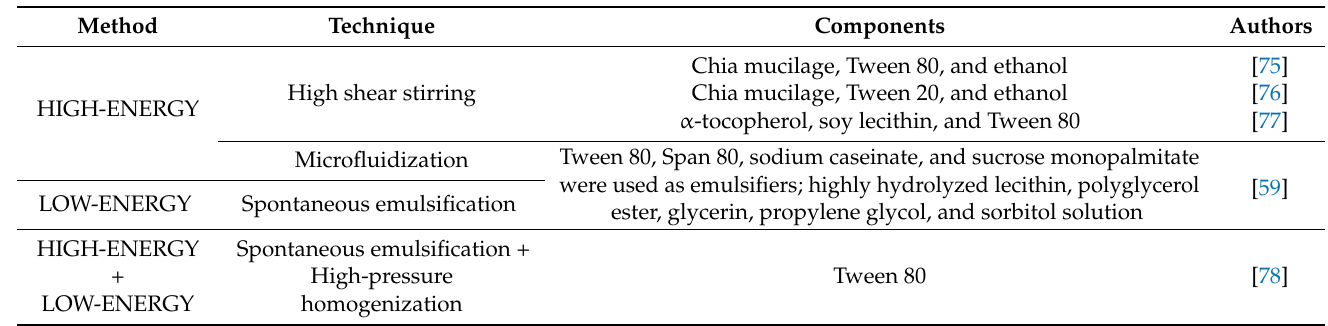
Table 1. Studies on the production of chia oil